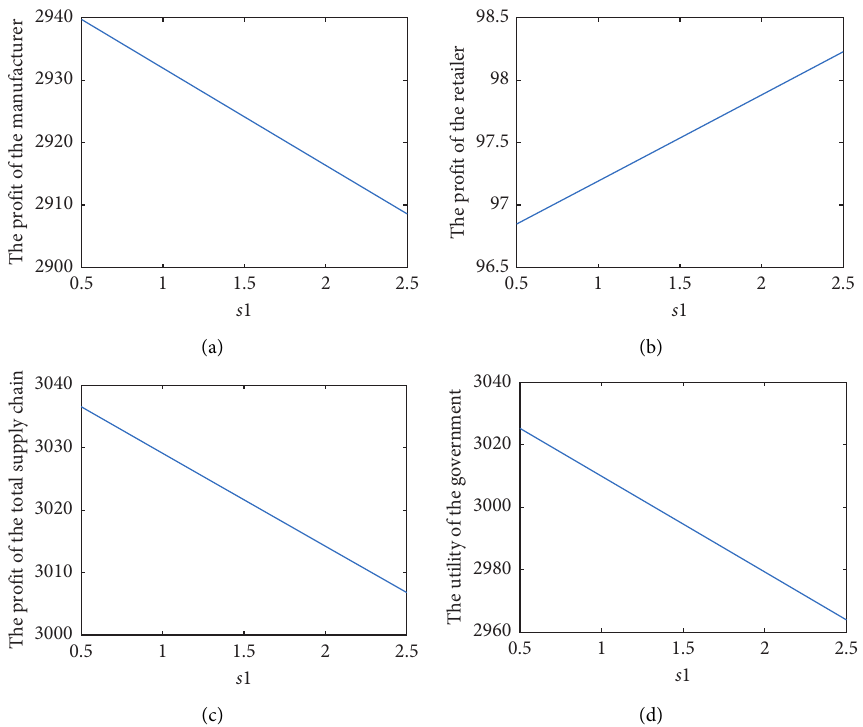
on prices and profits based on decentralized decision. 1